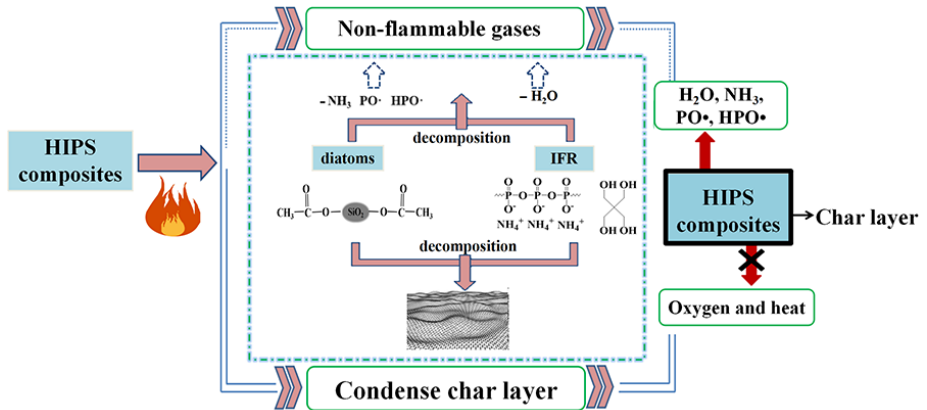
Figure 11. Possible flame retardant mechanism of the HIPS compounds.